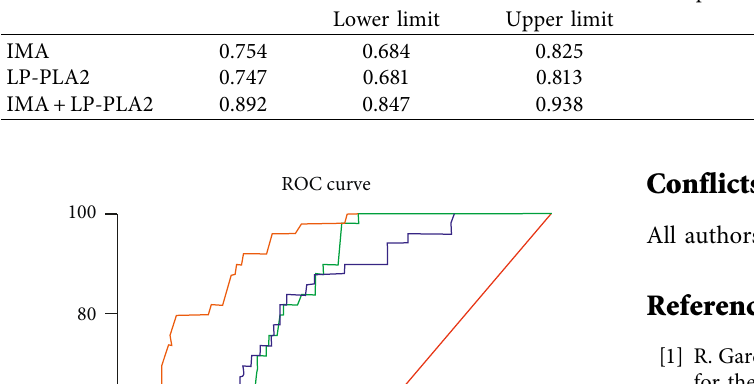
Table 5: Predictive value of serum IMA and LP-PLA2 levels for the development of myocardial ischaemia in patients with CHD.